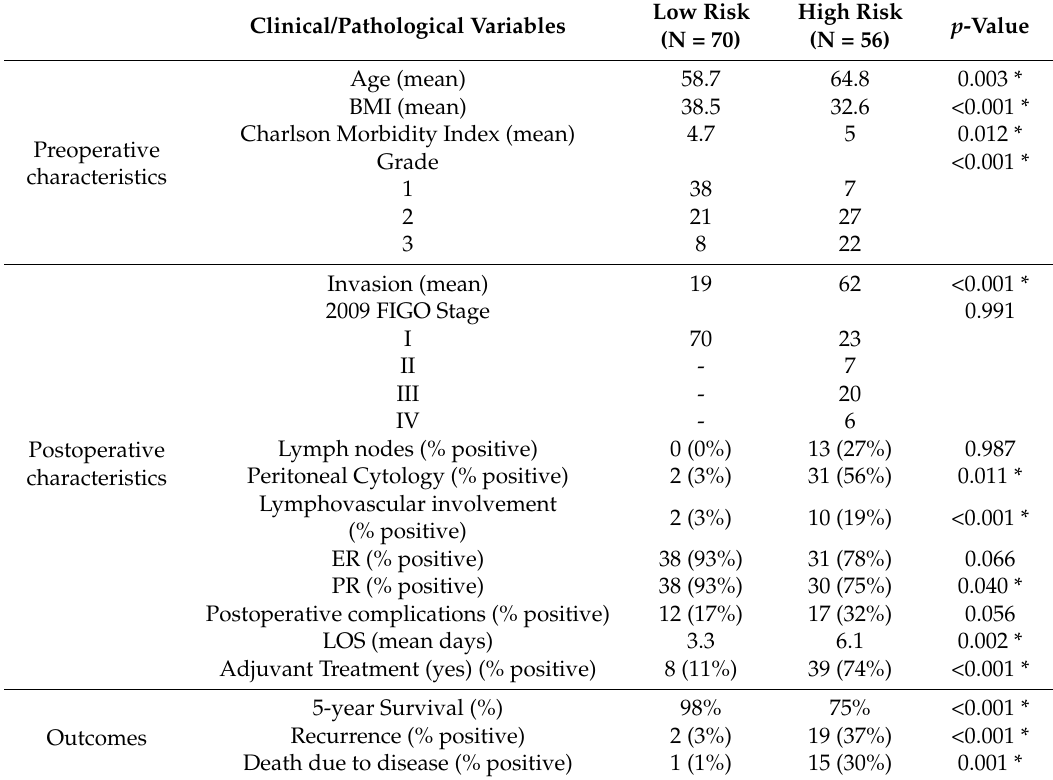
Figure 1. Flow chart of patients included in the University of Iowa (UI) endometrial cancer study cohort. (CHA = complex endometrial hyperplasia with atypia). In this dataset, 126 patients had endometrial cancer, the endometrioid type. Only 62 had sufficient quantity and quality of purified RNA for RNA sequencing. Table 1. Patient clinical and pathological characteristics. Univariate analysis with logistic regression was used to assess differences between both groups. * denotes statistically significant differences between low and high risk patients.